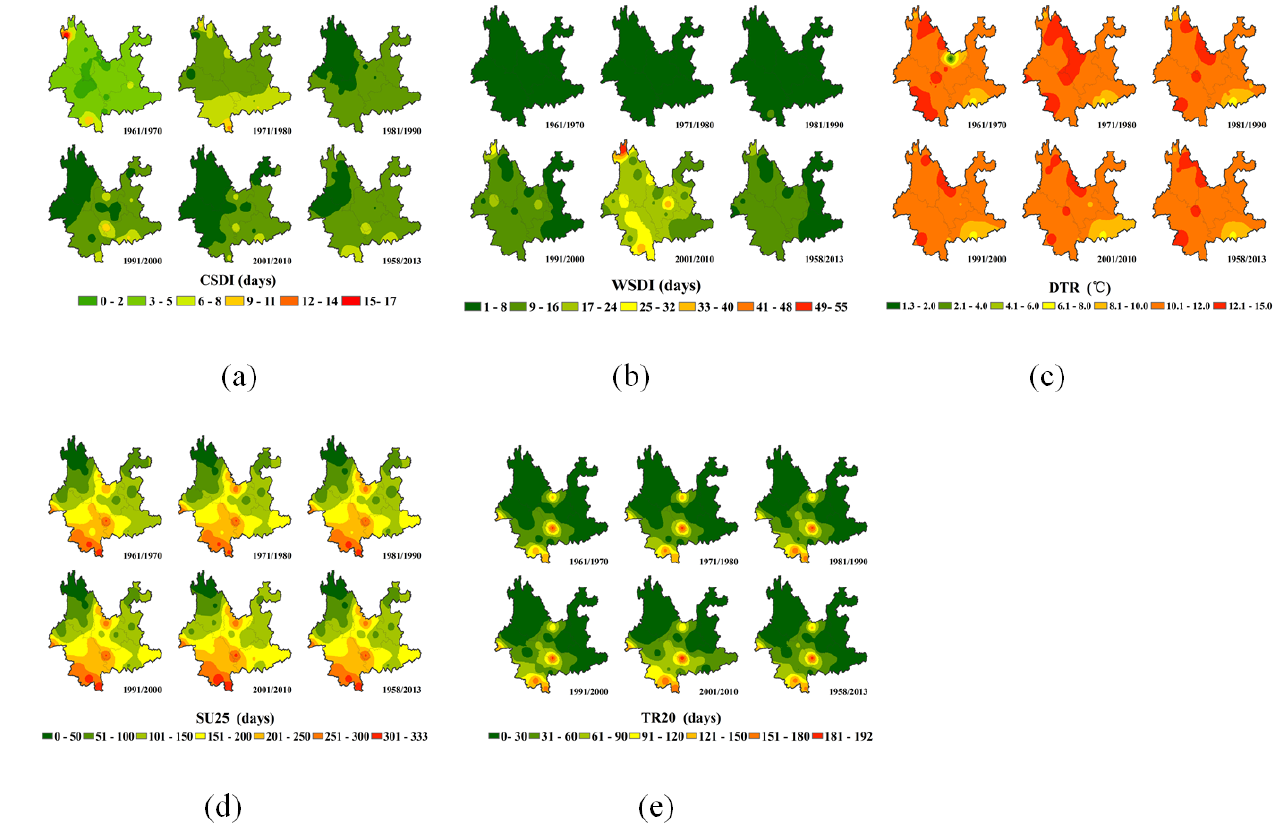
Figure 5. Spatial distribution of decadal mean extreme temperature indices in Yunnan Province during the period of 1958–2013 (a) CSDI, (b) WSDI, (c) DTR, (d) SU25 and (e)